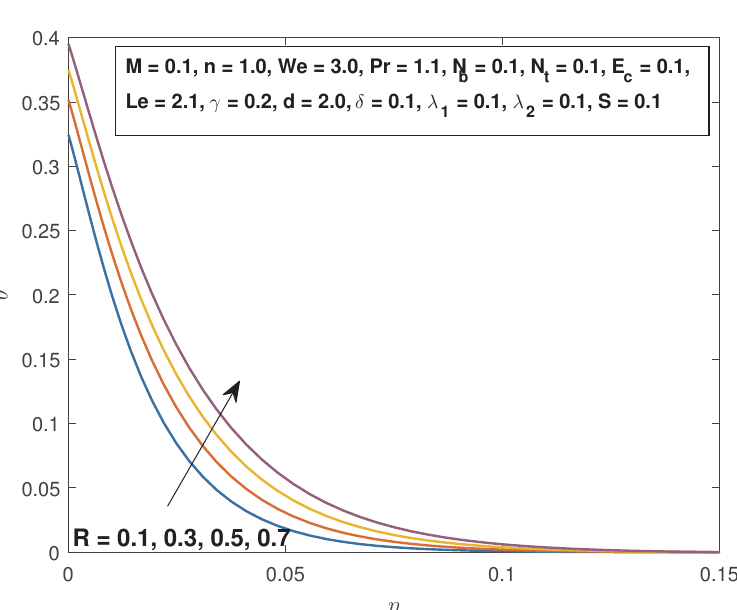
Figure 12. Influence of Pr on the fluid temperature.